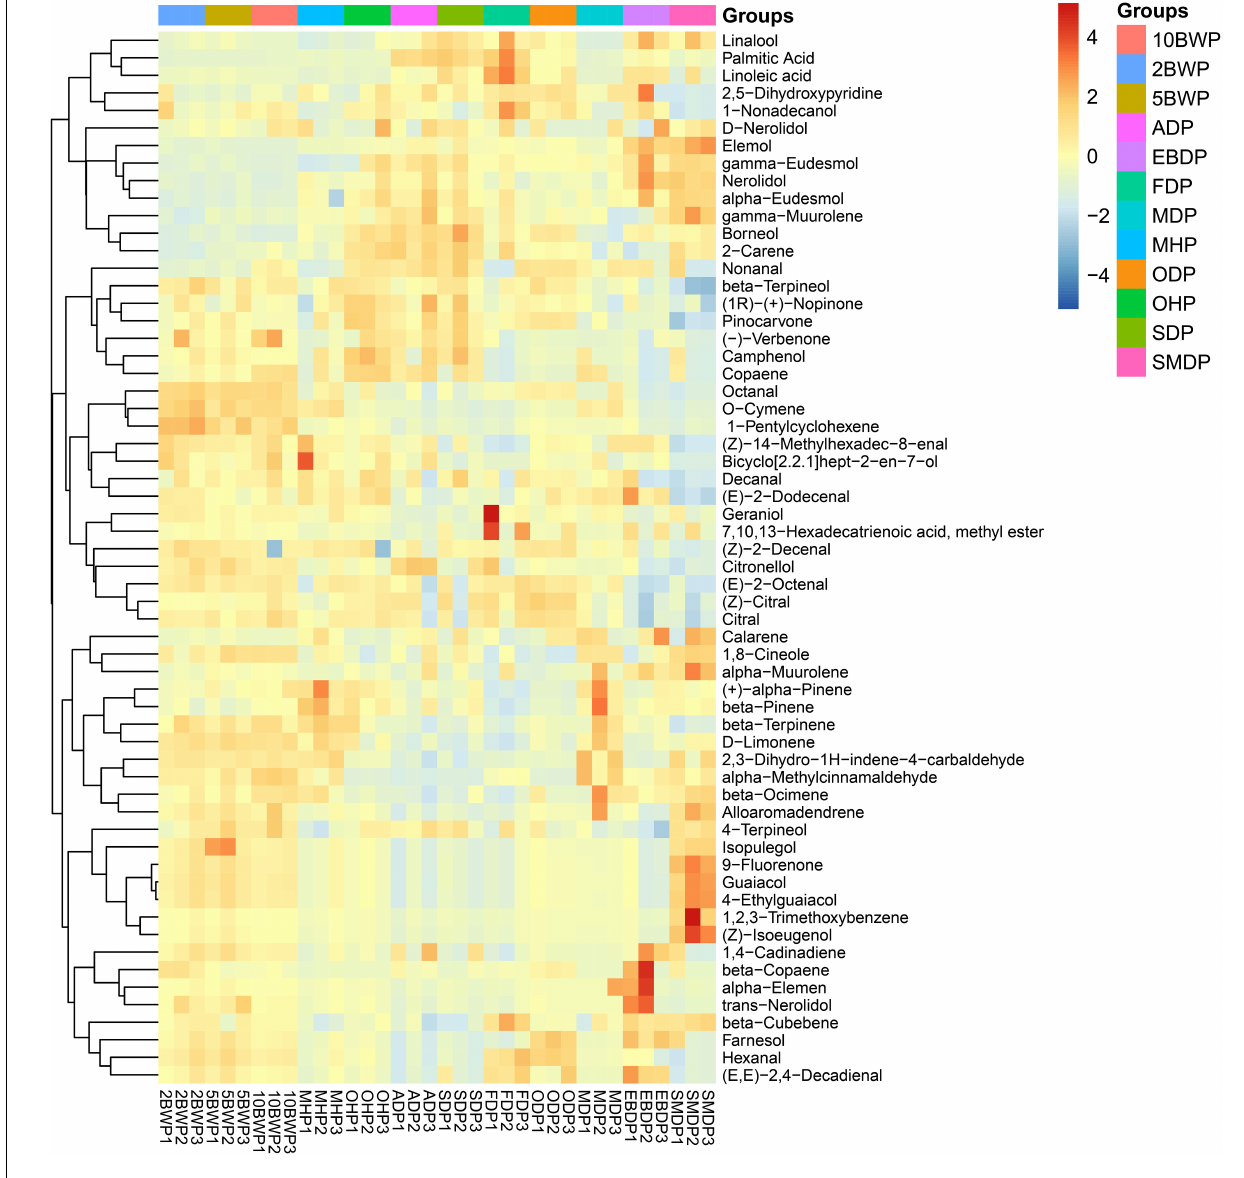
FIGURE 1 | Heat map visualization of volatiles in the pericarp of Amomum tsao-ko with different pre-drying and drying